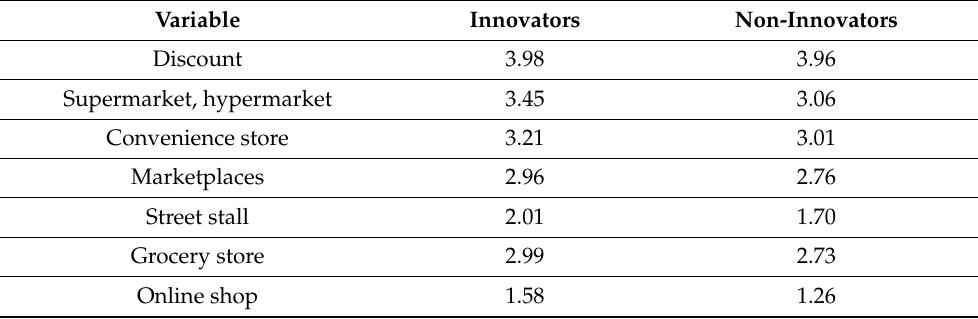
Table A2. Frequency * of purchasing fruit and fruit preserves at selected places of purchase of innovators and non-innovators.